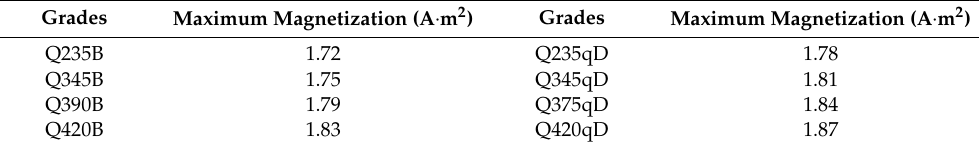
Table 2. Maximum magnetization intensity values of specimens with di ff erent grades.